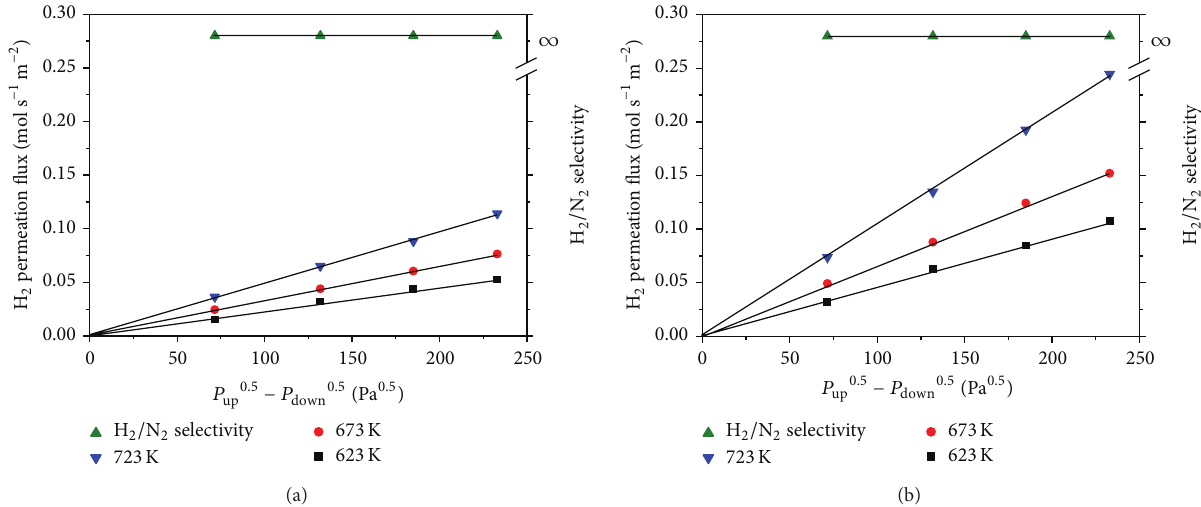
Figure 6: Hydrogen permeation flux and selectivity of membranes with (a) the purely dense structure and (b) dense/porous hybrid structure as a function of the pressure difference at various temperatures.